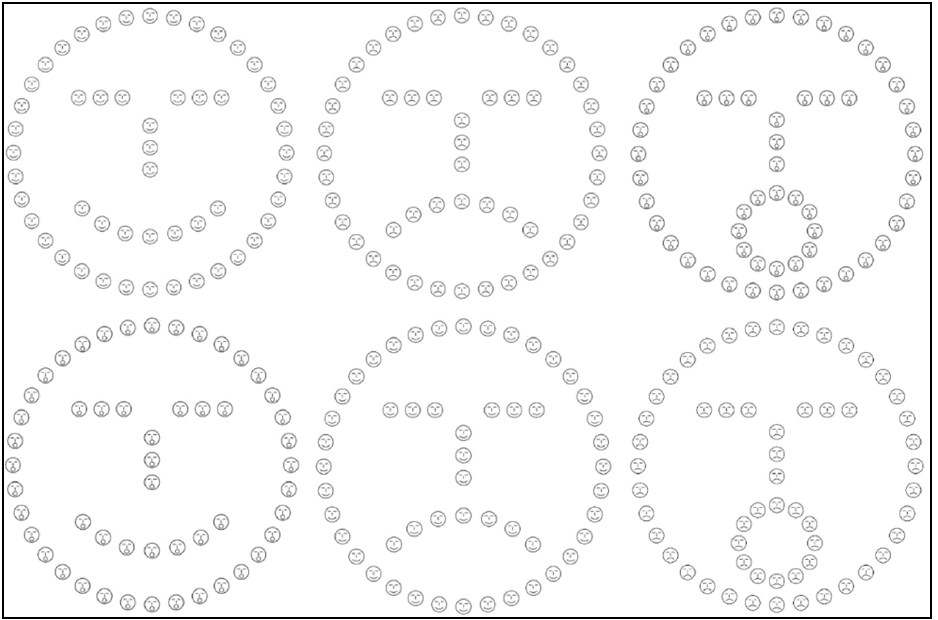
Figure 2. Hierarchical faces. Congruent stimuli are reported in the upper row, incongruent stimuli are reported in the lower row.